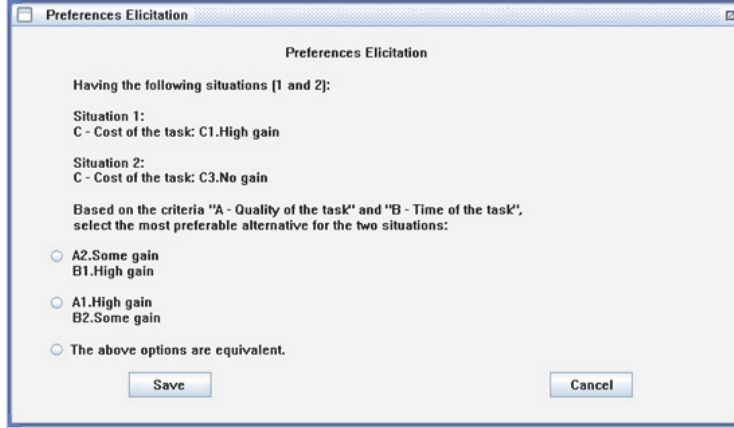
Figure 5: ARANA´U’s interface for structuring the problem scale of preferences between pairs of